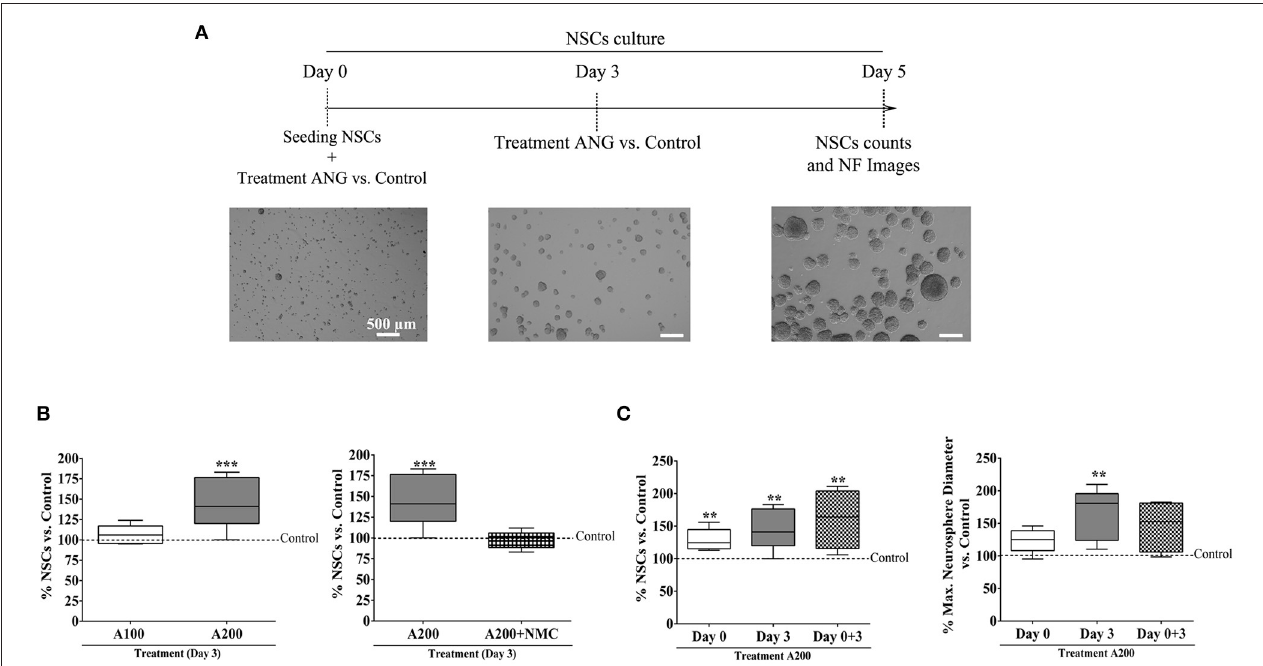
FIGURE 2 | SVZ-derived NSCs responses to angiogenin: (A) timeline of the experimental procedure of neurosphere cultures and representative images; (B,C) box plots showing quantification of the NSC-forming neurospheres after angiogenin stimulation (100 or 200ng/ml) at different time points, the inhibition with neomycin, and the largest neurosphere diameters obtained with angiogenin treatment; n = 4–9; ** p < 0.001 and *** p < 0.001 vs. control. Box plots represent median (IQR) of the percentage vs. control values of each independent experiment. ANG/A, angiogenin; NSCs, neural stem cells; NMC, neomycin; NF,